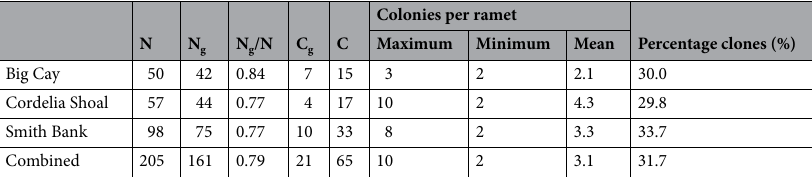
Table 1. Description of ramet and clonal diversity of Acropora cervicornis within the Cordelia Bank Site of Special Importance to Wildlife. N, is the total number of colonies sampled; N g , is the number of unique genotypes identified; N g /N is the genotype to colony ratio; C g is the number of ramets identified; C is the total number of colonies identified as clones. No significant difference in the number of clones per bank (chi- squared = 4.125 p = 0.127), the number clonal genets per bank (chi-squared = 1.348 p = 0.510), or the mean ramets per genotype per bank (chi-squared = 0.392 p = 0.822) were